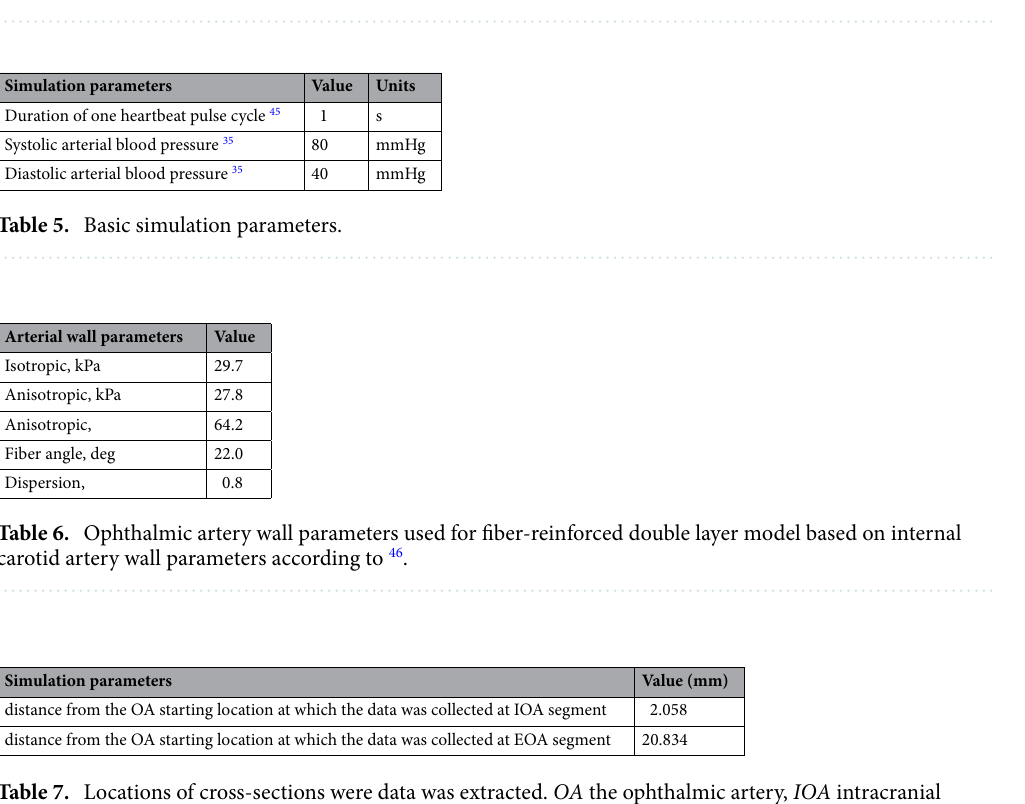
Table 7. Locations of cross-sections were data was extracted. OA the ophthalmic artery, IOA intracranial segment of the ophthalmic artery, EOA extracranial segment of the ophthalmic artery.